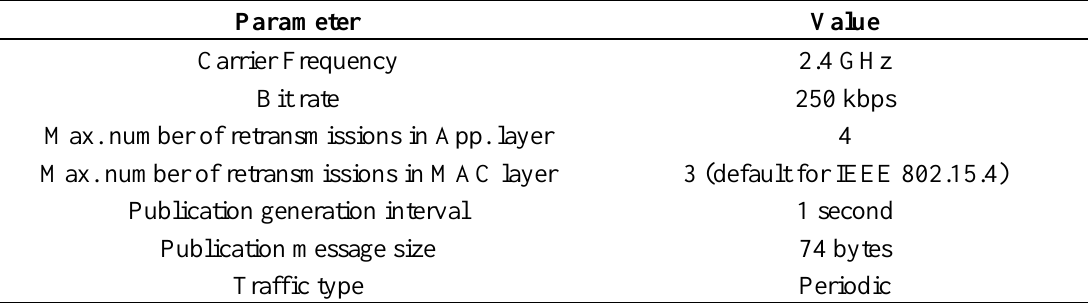
Table 2. Parameter setting for